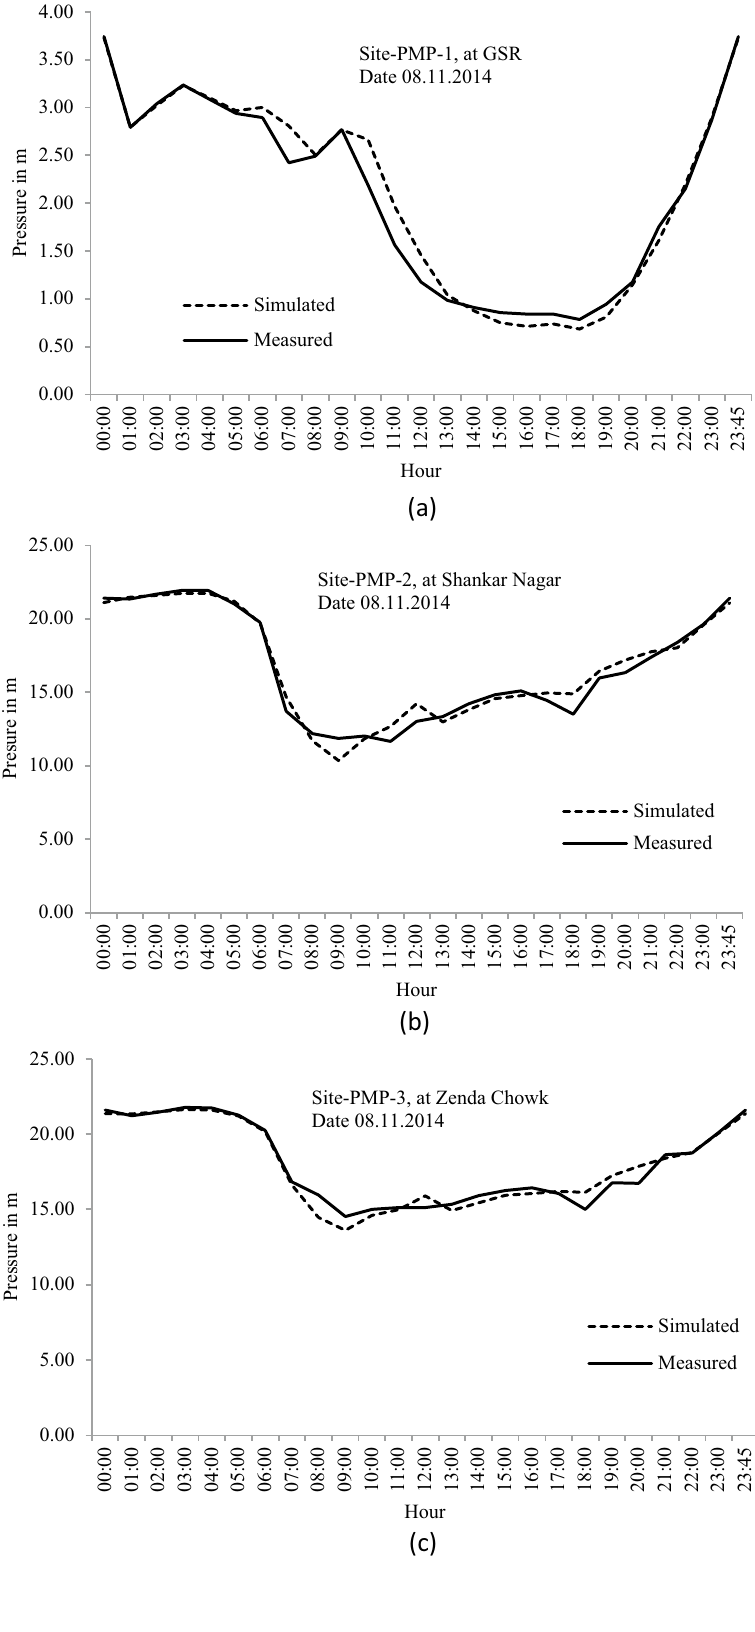
Fig. 2 Comparison of simulated pressure heads with those meas- ured in the field after